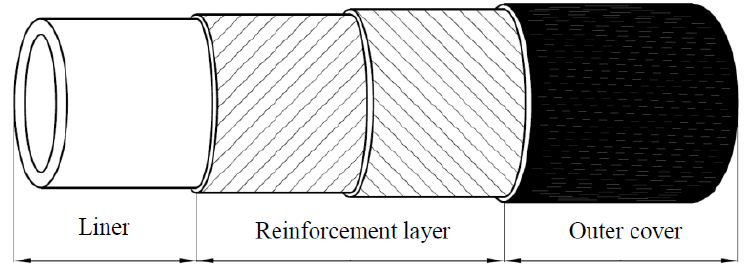
Figure 1. Typical structure of RTP.